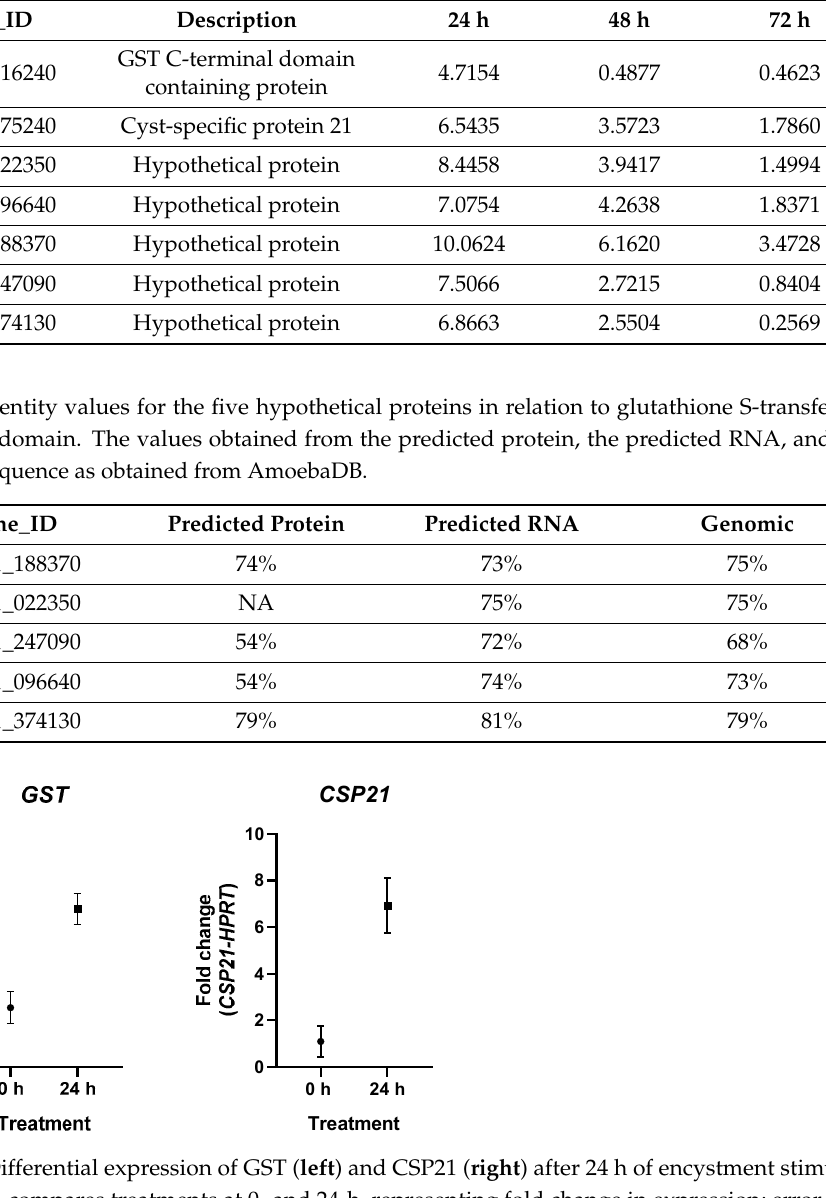
Table 2. Log2FC values for hypothetical proteins related to GST c-terminal compared against gene expression at 0 h. The table includes values for the original glutathione S-transferase C-terminal domain containing protein and the cyst-specific protein 21 as reference.